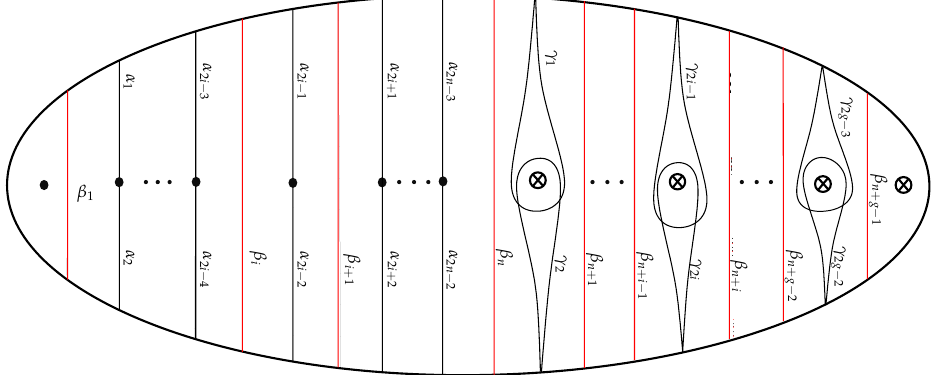
Figure 1. The arcs α i , β i , γ i and the core curves c i of the crosscaps on N g , n